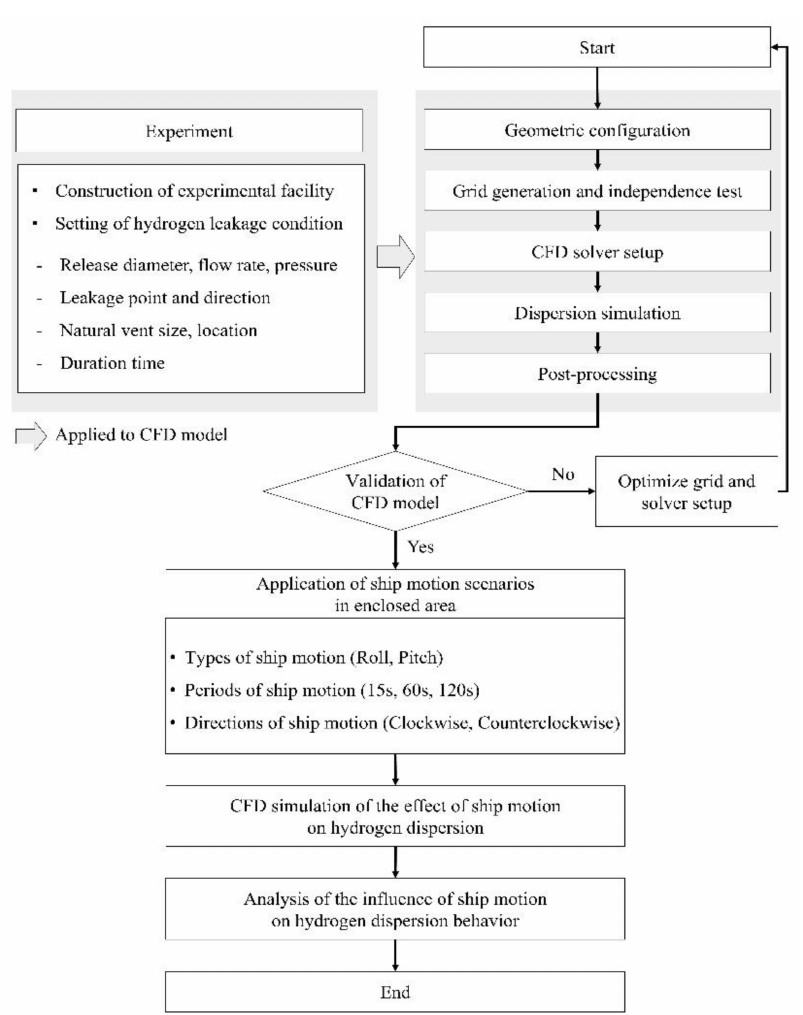
Figure 1. Flowchart of overall